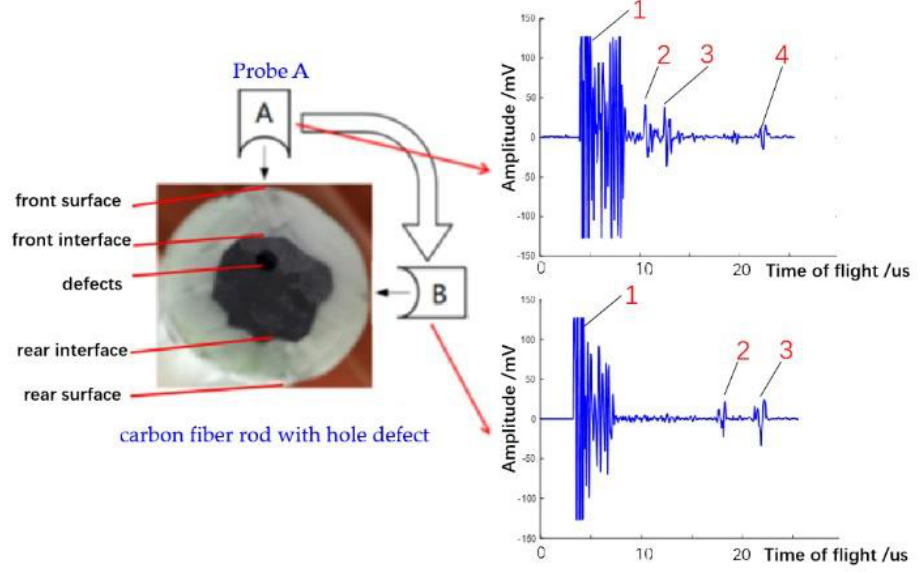
Figure 7. Ultrasonic reflection signal of carbon fiber rod with hole defect.